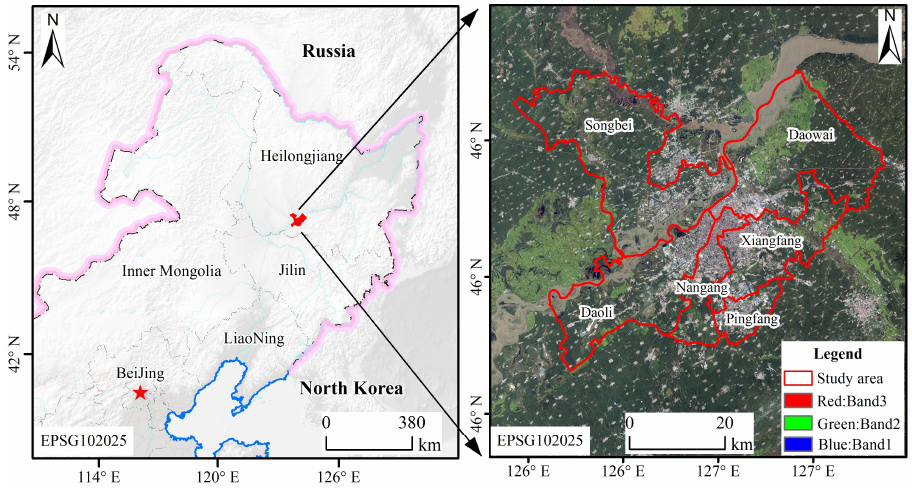
Figure 1. The location of the study area in Harbin.